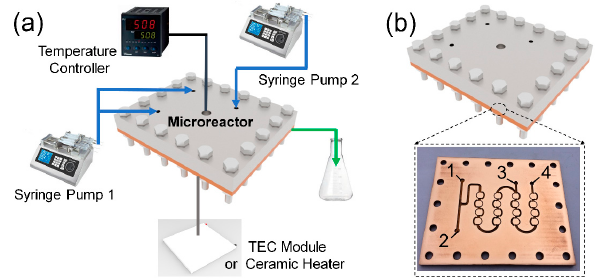
Figure 1. ( a ) Schematic diagram of the microchannel reactor and ( b ) enlarged diagram of the dislocated snake-like microchannel.